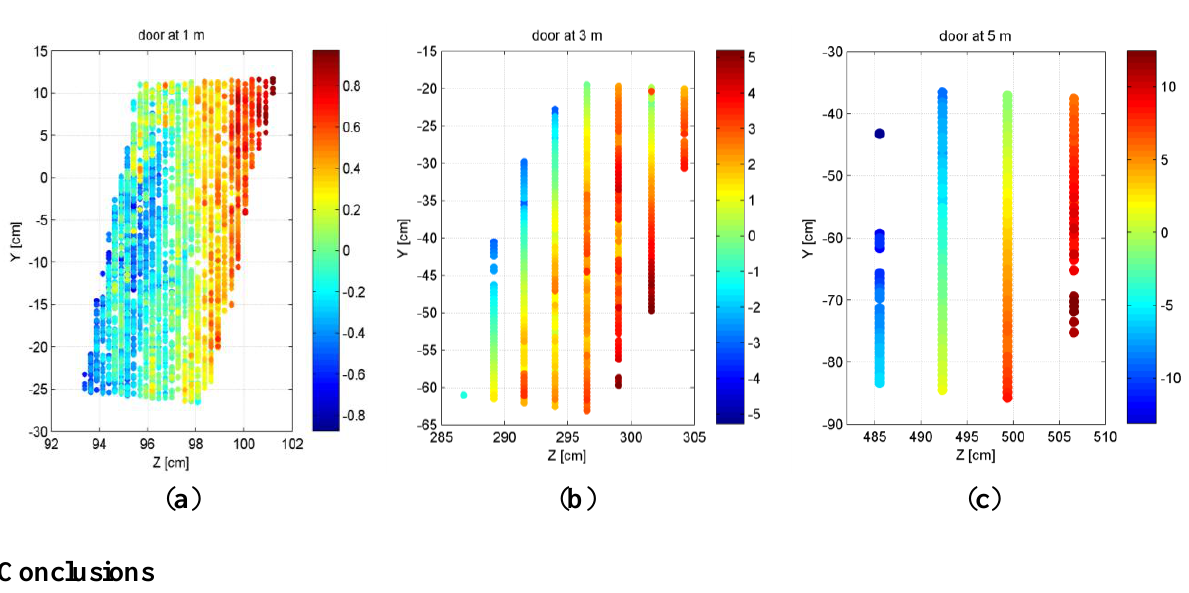
Figure 11. Point cloud of a planar surface at 1 meter ( a ), 3 meter ( b ) and 5 meter ( c ) distance from the sensor projected on the Y-Z plane. Colors represent distance to the best-fit plane in